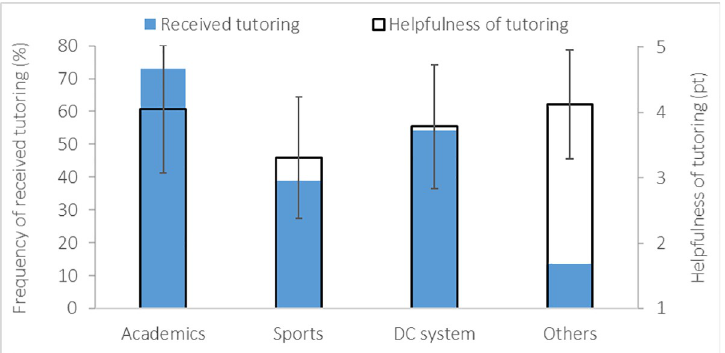
Fig 9. Mean and standard deviation of tutoring/counselling provided to student-athletes by academics, sports, Dual Career (DC) systems, and others (left vertical axis) and helpfulness of tutoring services if received (right vertical axis).